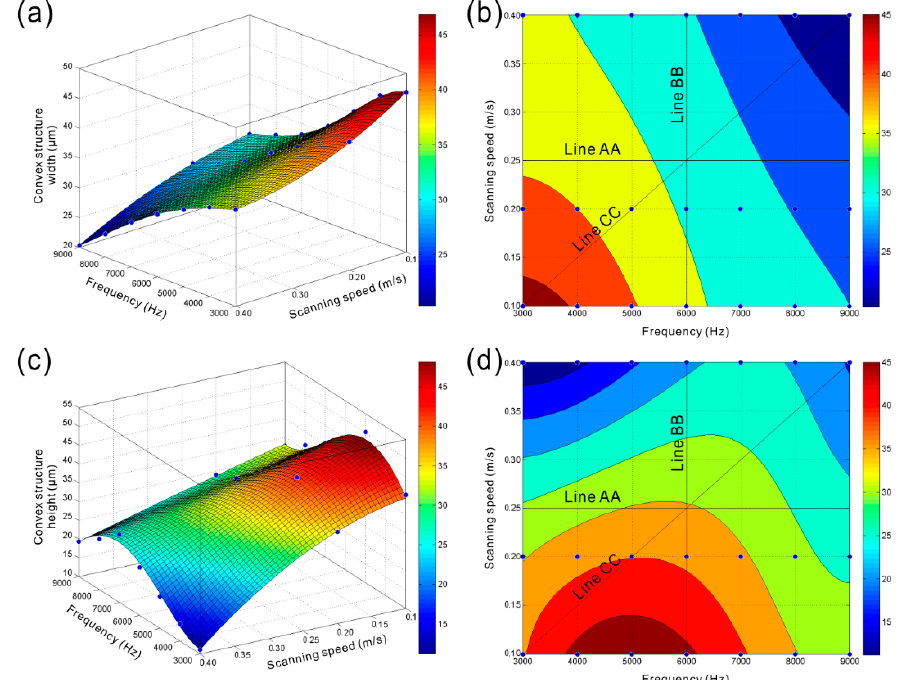
Figure 13. ( a , b ) Variations of convex structure width of the strip microstructure with laser beam pulse frequency and scanning speed; ( c , d ) Variations of convex structure height of the strip microstructure with laser beam pulse frequency and scanning speed.